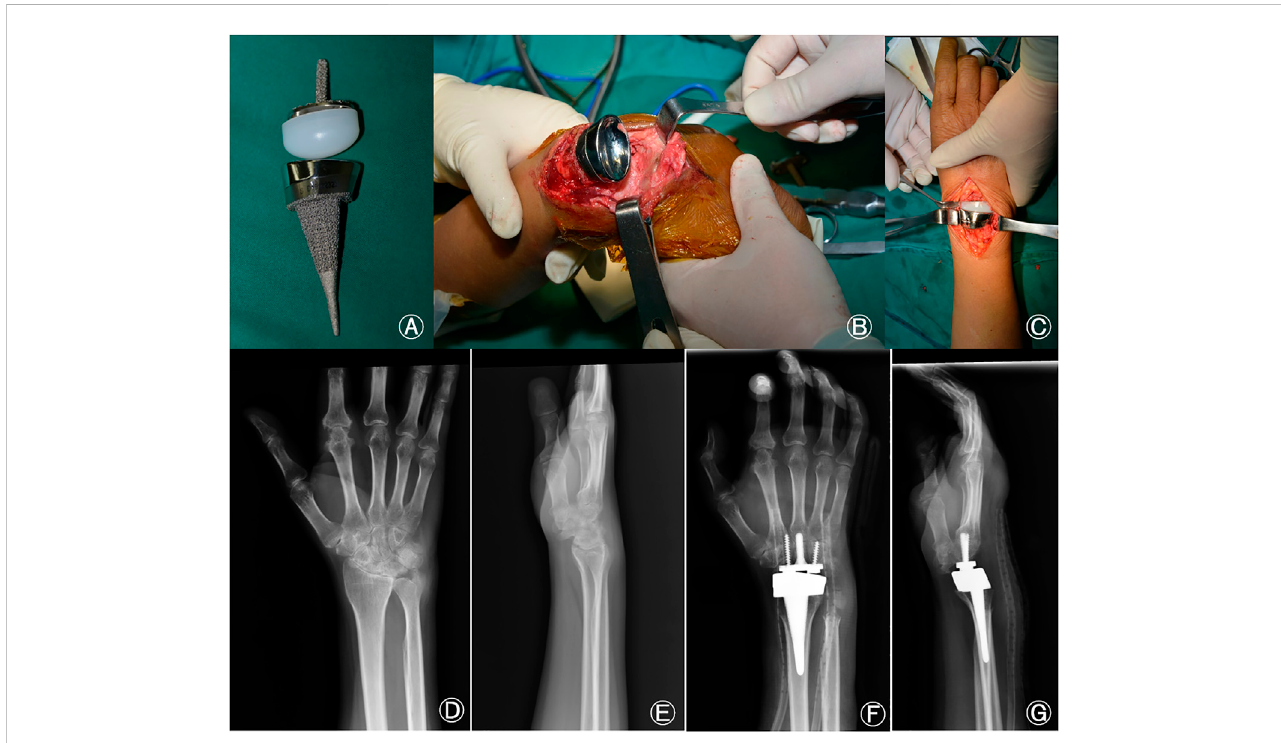
FIGURE 1 (A) Microporous titanium total wrist joint prosthesis, (B) Intraoperative carpal and radial osteotomy have been completed and the radial component is being installed. (C) Polyethylene has been inserted into the carpal component and the arti fi cial wrist joint has been reset, (D) Preoperative